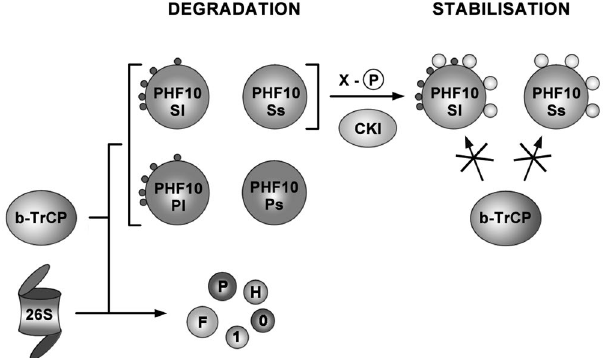
Figure 8. The diagram of PHF10 degradation. PHF10 in mammalian cells is represented by four isoforms which differ by their N-terminal and C- terminal domains. Sl and Pl isoforms have additional 47 N-terminal amino acids while Pl and Ps isoforms have C-terminal double PHD domains. All PHF10 isoforms undergo β -TrCP targeted degradation, however their stability is different and depends upon post-translational phosphorylation which in turn depends upon their domain structure. Two main phosphorylation patterns designated as Y-phosphorylation and X-phosphorylation were identified in PHF10. Y-phosphorylation (black circles) was found in Sl and Pl isoforms and depends upon the presence of 47 N-terminal amino acids. X-phosphorylation (light circles) which is determined by the absence of PHD domains is present in Sl and Ss isoforms. Importantly X-phosphorylation impairs interaction of Sl and Ss isoforms with β -TrCP and thus opposes their